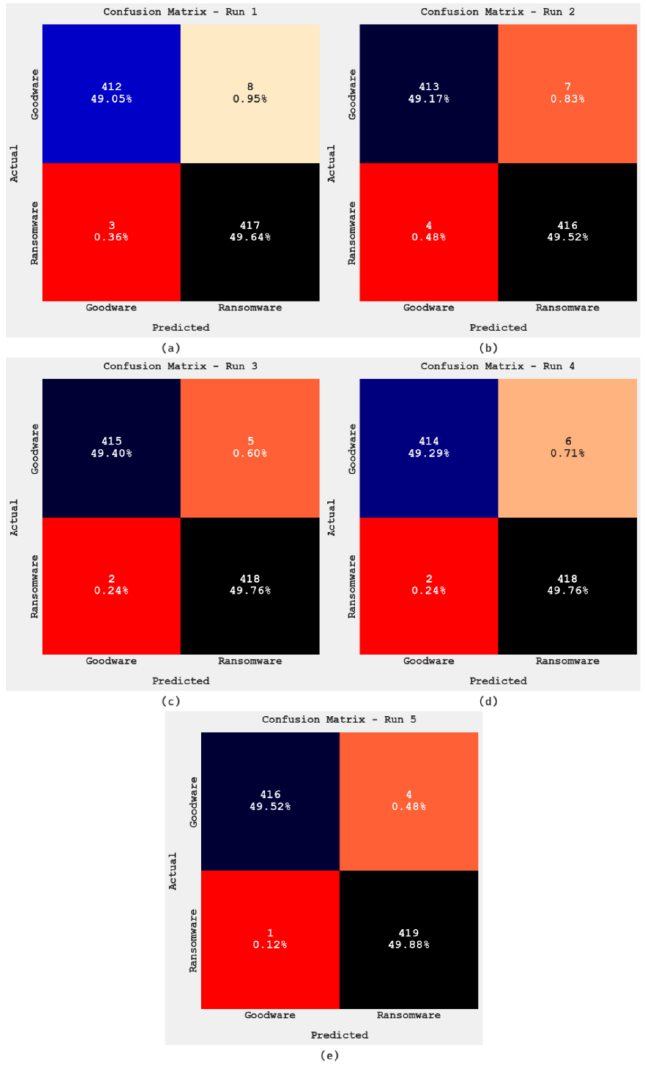
Figure 3. Confusion matrices of DWOML-RWD approach: ( a ) run-1, ( b ) run-2, ( c ) run-3, ( d ) run-4, and ( e ) run-5.